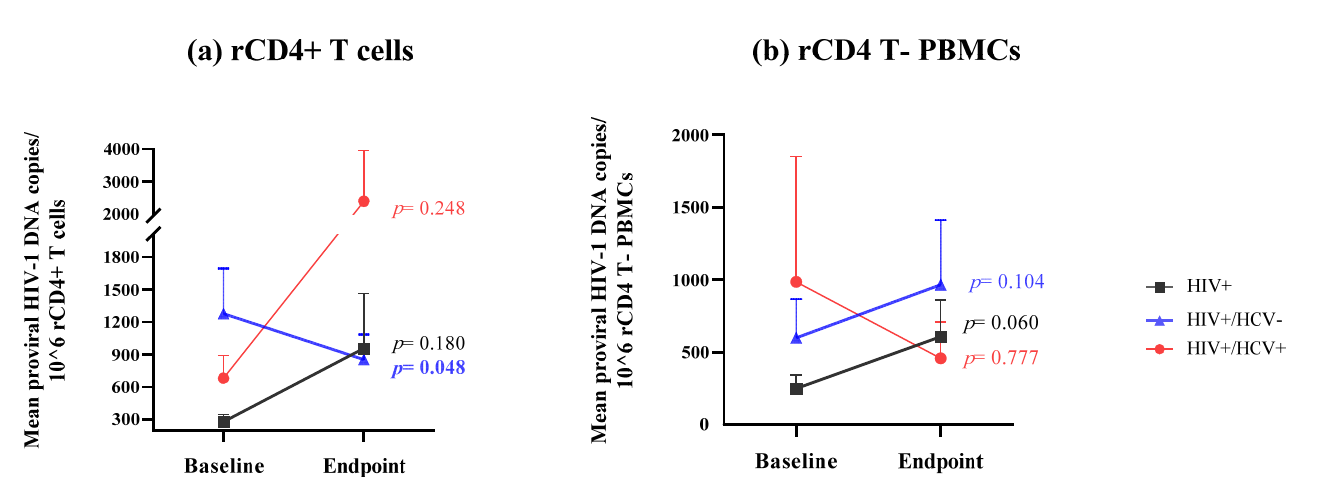
Figure 1. Evolution of HIV-reservoir size in ( a ) rCD4+ T cells and ( b ) rCD4 T- PBMCs. Footnote: The study groups were: (1) HIV+: PLWH; (2) HIV+/HCV-: PLWH and HCV, who spontaneously cleared HCV infection; and (3) HIV+/HCV+: PLWH and HCV, who were never treated for HCV at baseline but achieved a sustained viral response with direct-acting antivirals at endpoint. Symbols with connecting lines represent reservoir-size arithmetic mean and standard error of the mean. Differences between baseline and endpoint for the different study groups were calculated using a mixed-model Gamma-distributed GLM. Statistical significance was defined as p < 0.05 (2-tailed). HIV, human immunodeficiency virus; HCV, hepatitis C virus; rCD4+ T cells, resting CD4+ T cells; rCD4 T- PBMCs, resting CD4 T cells-depleted PBMCs; baseline, time of the study when HIV+/HCV+ individuals had never been treated for hepatitis; endpoint, time of the study when HIV+/HCV+ subjects had cleared HCV by treatment with direct-acting antivirals. HIV viral-splicing expression and dynamics.